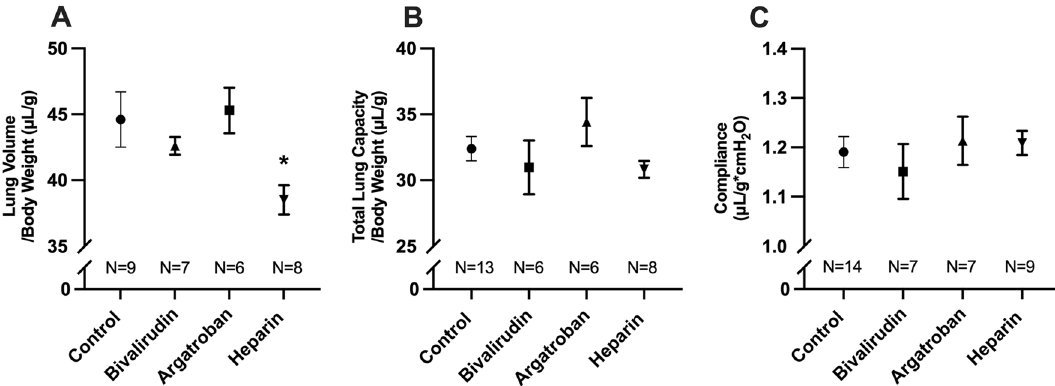
Figure 2. Lung growth and pulmonary function testing. Heparin administration impaired compensatory lung growth, as demonstrated by significantly decreased lung volume compared to controls ( A ). Lung volume was not different in the bivalirudin or argatroban groups. Total lung capacity was lowest for heparinized mice, although there were no significant differences between groups ( B ). Although heparin affected lung growth, there were no differences in pulmonary compliance across all four groups ( C ). Statistical analysis of the experimental groups was done using analysis of variance (ANOVA), with Dunnett’s adjustment for multiple comparisons. TLC and lung volumes were normalized to mouse body weight. Shown are mean ± standard error. *P < 0.05.